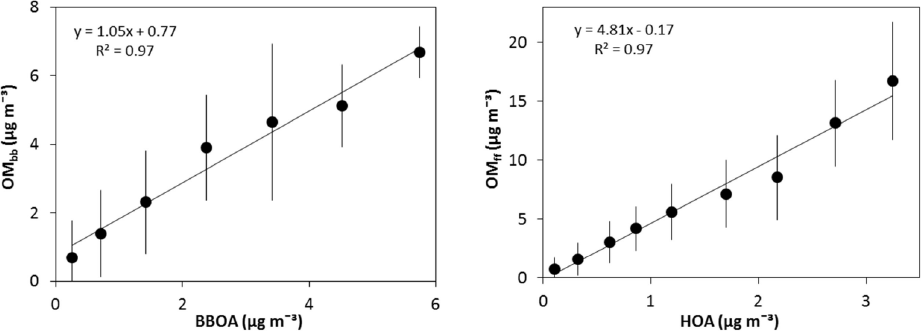
Figure 4. Scatter plot by bins between OM ff and HOA and between OM bb and BBOA for AAE bb = 2 and AAE ff = 1 at MSY (on an hourly basis).